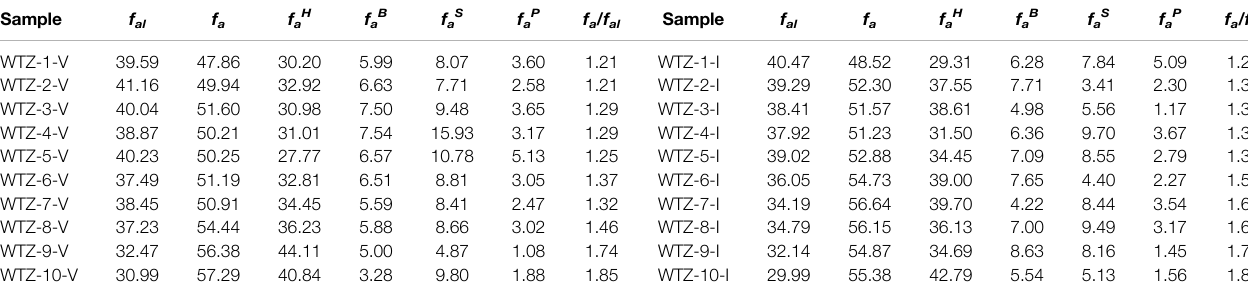
Frontiers in Earth Science |